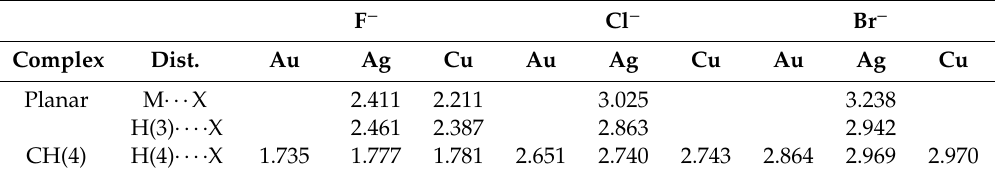
Table 6. Geometrical intermolecular distances (Å) in the 1:3 complexes. F